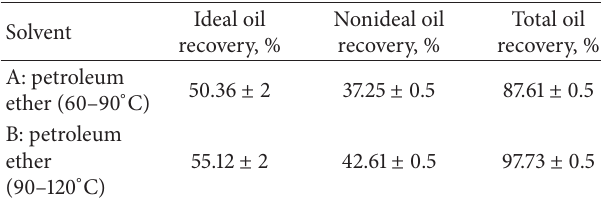
Table 1: Properties of spent clay. Table 2: Effect of petroleum ethers with different boiling range.